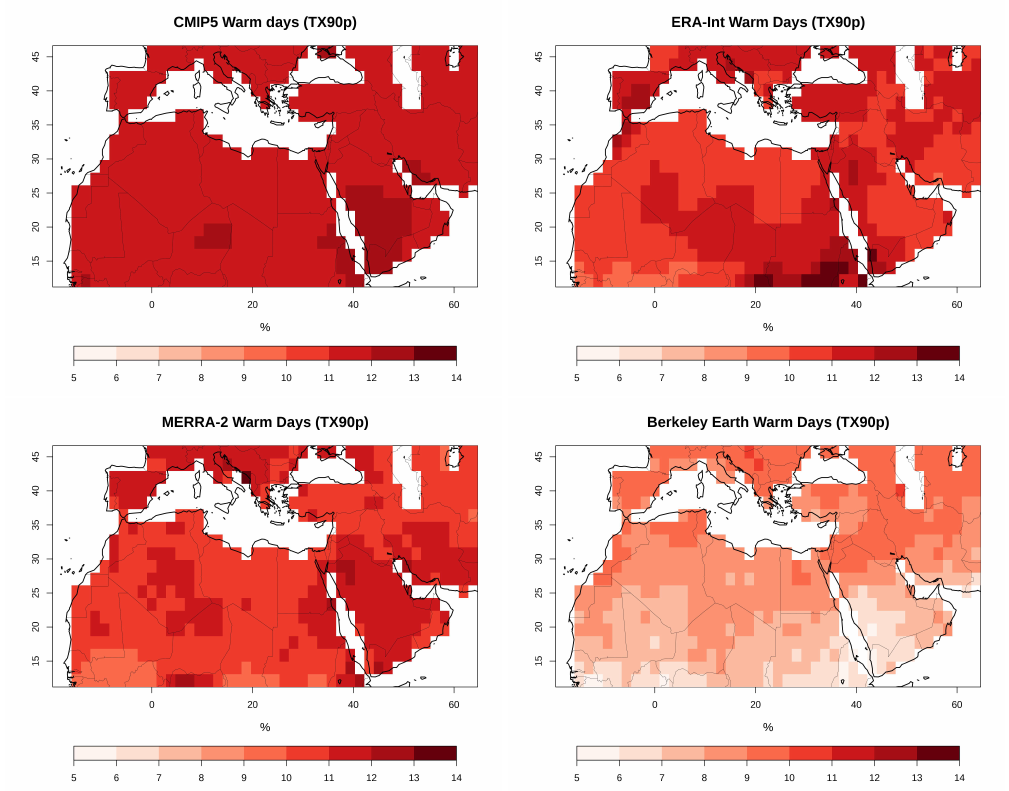
Figure 4. 1980–2018 climatology of the exceedance rate of Warm Days (TX90p) for the: CMIP5 multi-model ensemble mean ( top left ), ERA-Interim ( top right ), MERRA-2 ( bottom left ), and Berkeley Earth ( bottom right